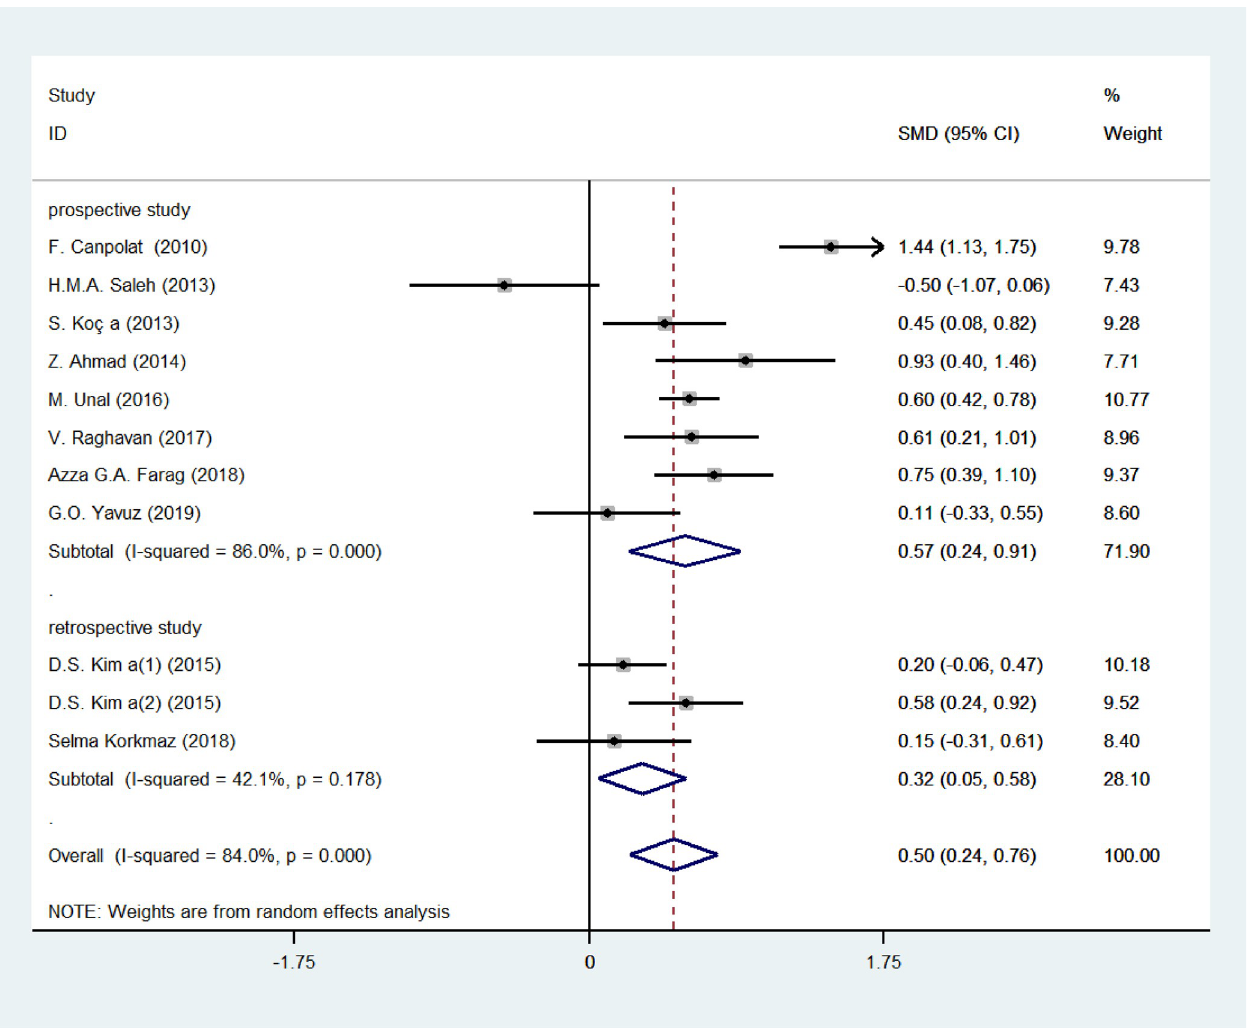
Fig 6. Stratified analyses of study type for the association between MPV and psoriasis.